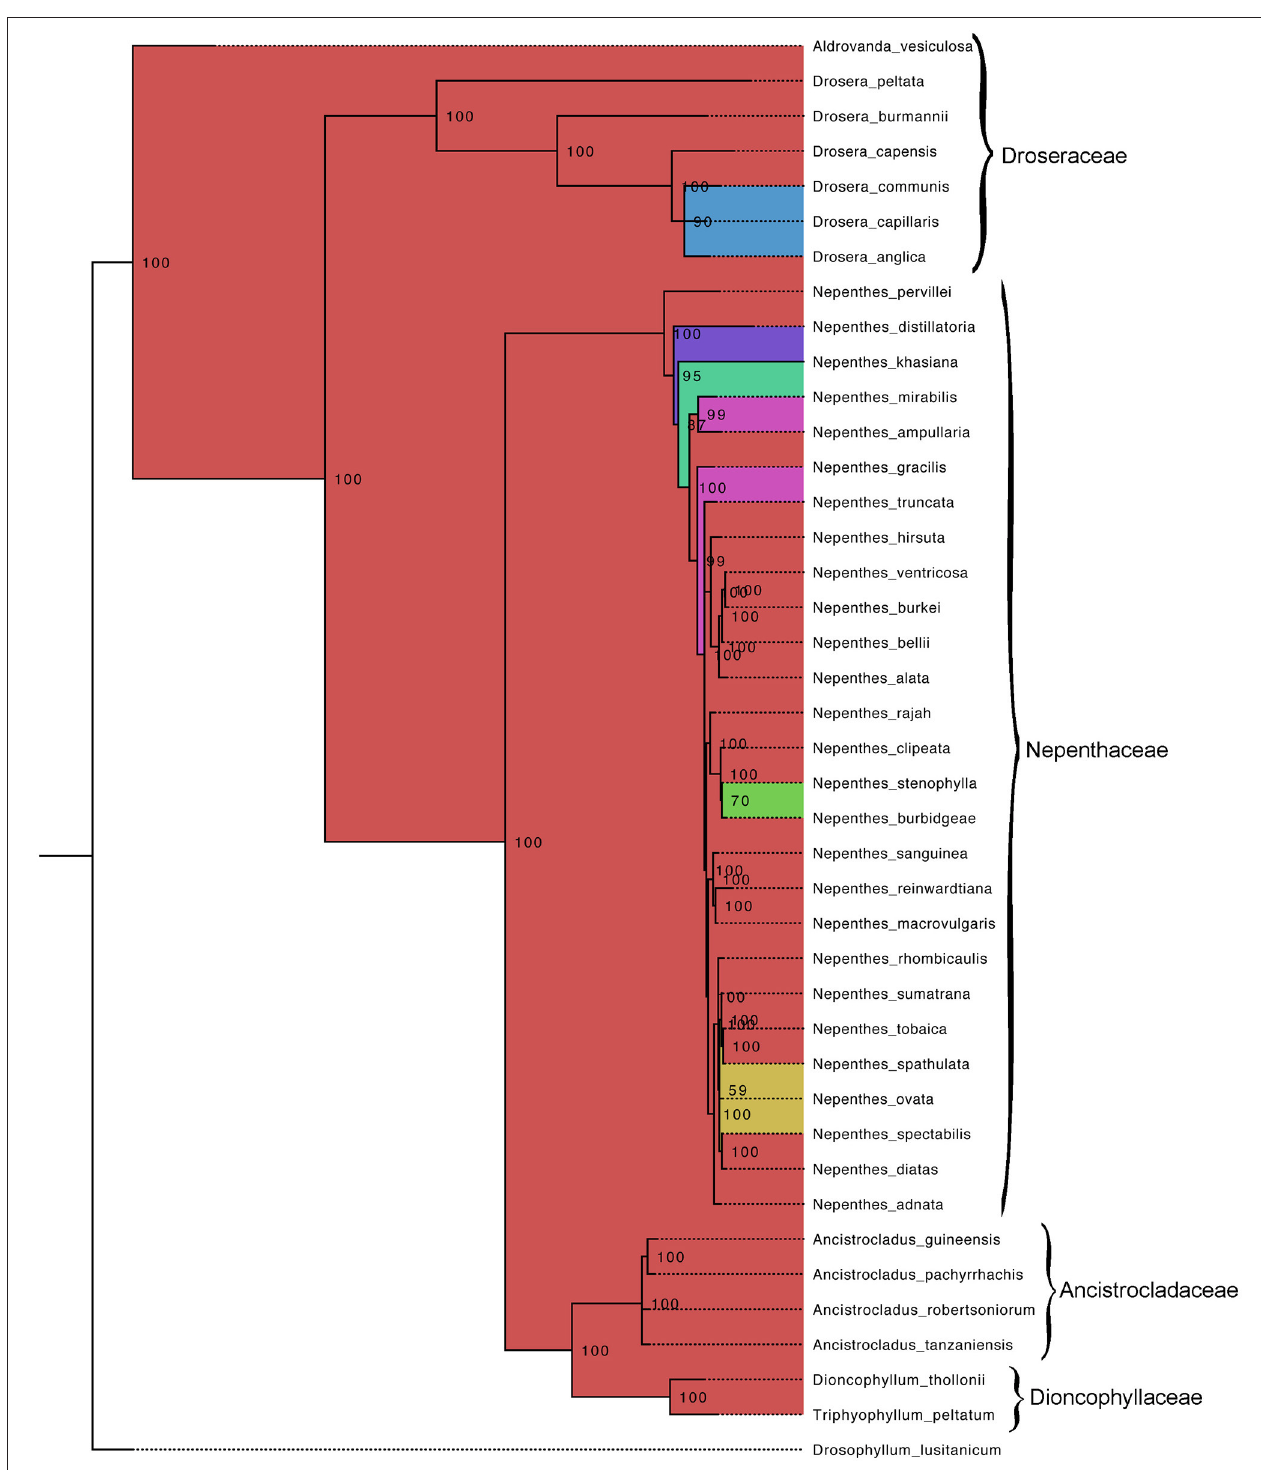
FIGURE 1 | Bayesian phylogenies of Nepenthaceae, Droseraceae, Drosophyllaceae, Dioncophyllaceae, and Ancistrocladaceae based on concatenated plastid markers. Phylogenetic analysis are based on plastid (ITS and matK) sequence data with posterior probabilities > 0.85. Bayesian phylogeny reconstruction obtained by posterior probabilities (BPP) for the nodes in the ML tree. GTR evolutionary model was implemented in MrBayes 3.2 with four chains during 100,000 generations and trees were sampled every 100 generations.